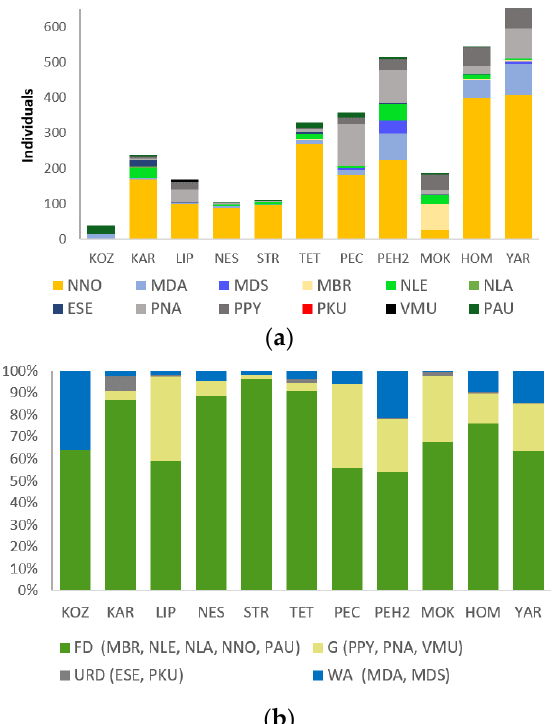
Figure 3. ( a ) Numbers of different bat species in each study plot. ( b ) The ratio of bat species from different ecological groups by study plots. WA — water-associated; FD — forest-dwelling specialists; G — generalists; URD — urban- and rural-dwellers.